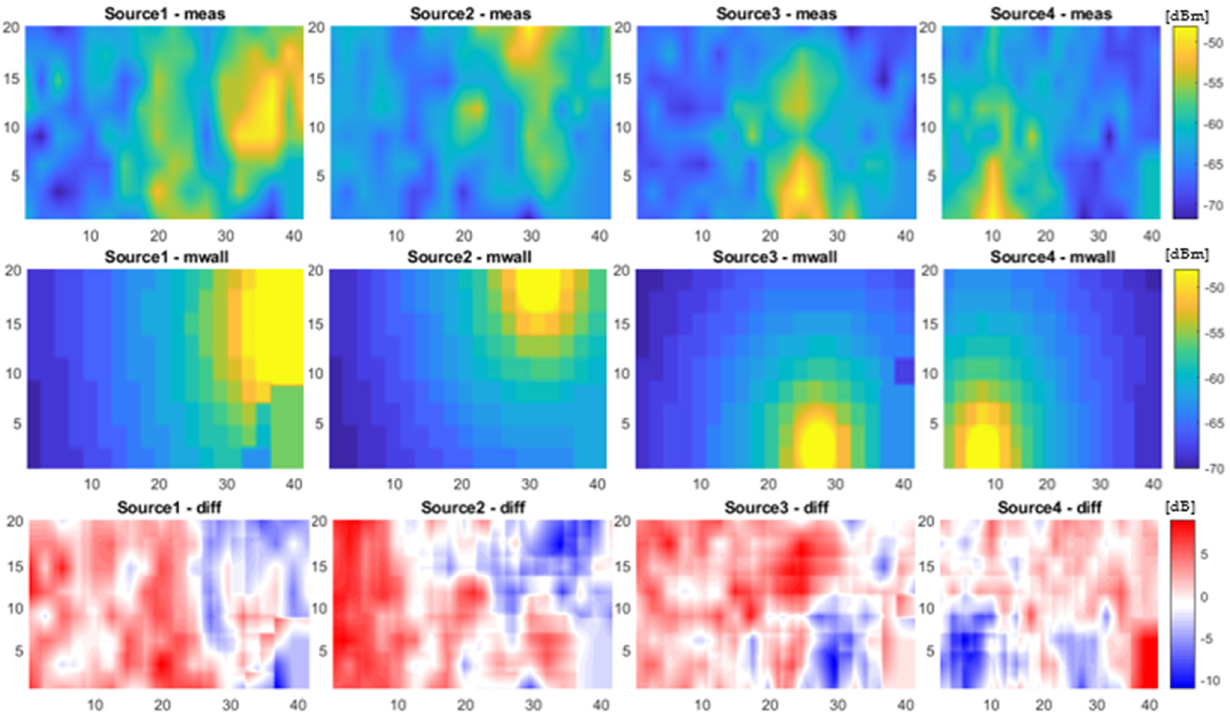
Figure 12. Comparison of reference RSSI maps created by measurements and simulations using the ray tracing method. Row 1—measurement data. Row 2—distributions generated by ray tracing. Row 3 is the result of calculating the subtraction between these maps presented on the spatial map.